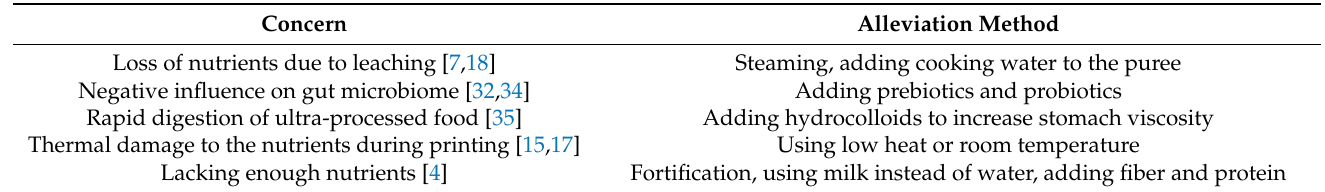
Table 3. Summary of nutritional concerns and suggested alleviation methods for 3D-printed dyspha- gia